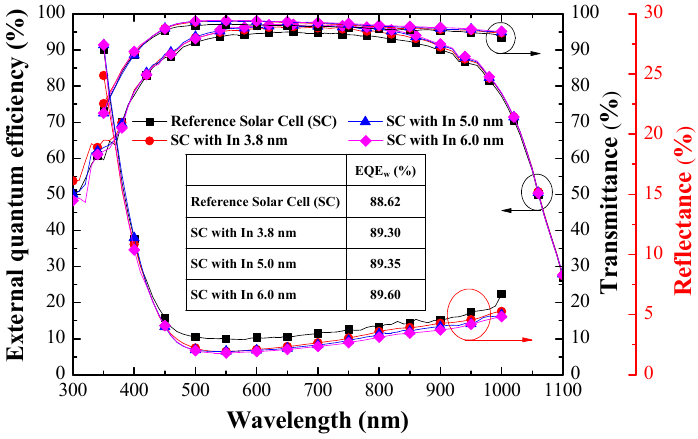
Figure 7. EQE response of reference solar cell (textured silicon but without NPs) and textured silicon solar cell coated with In NPs of various dimensions under normal incidence (θ = 0°).